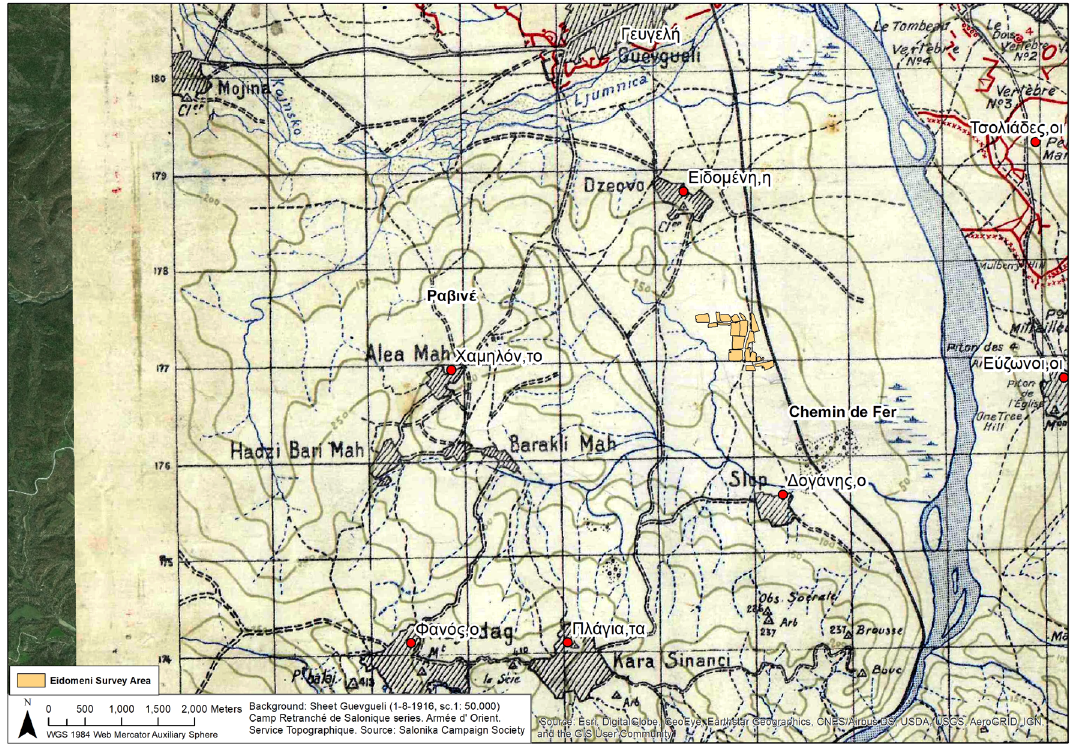
Figure 15. The landscape with Muslim settlements. The landscape as a theater of military operations August 1916 before the operations at Dogani Hill (Mamelon du Chemin de Fer) and Ravine Height (Source of military map: Salonica Campaign Society, WGS 1984, WebMercator Auxiliary